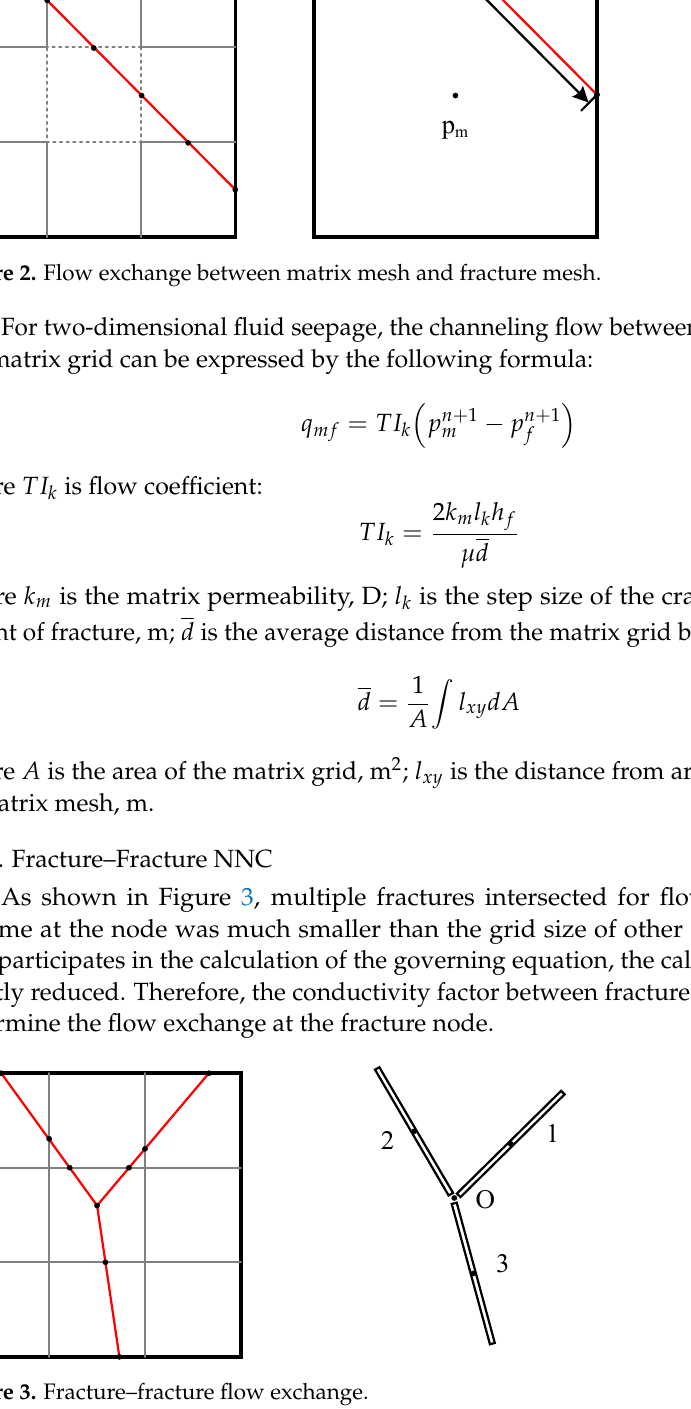
Figure 3. Fracture–fracture flow exchange.